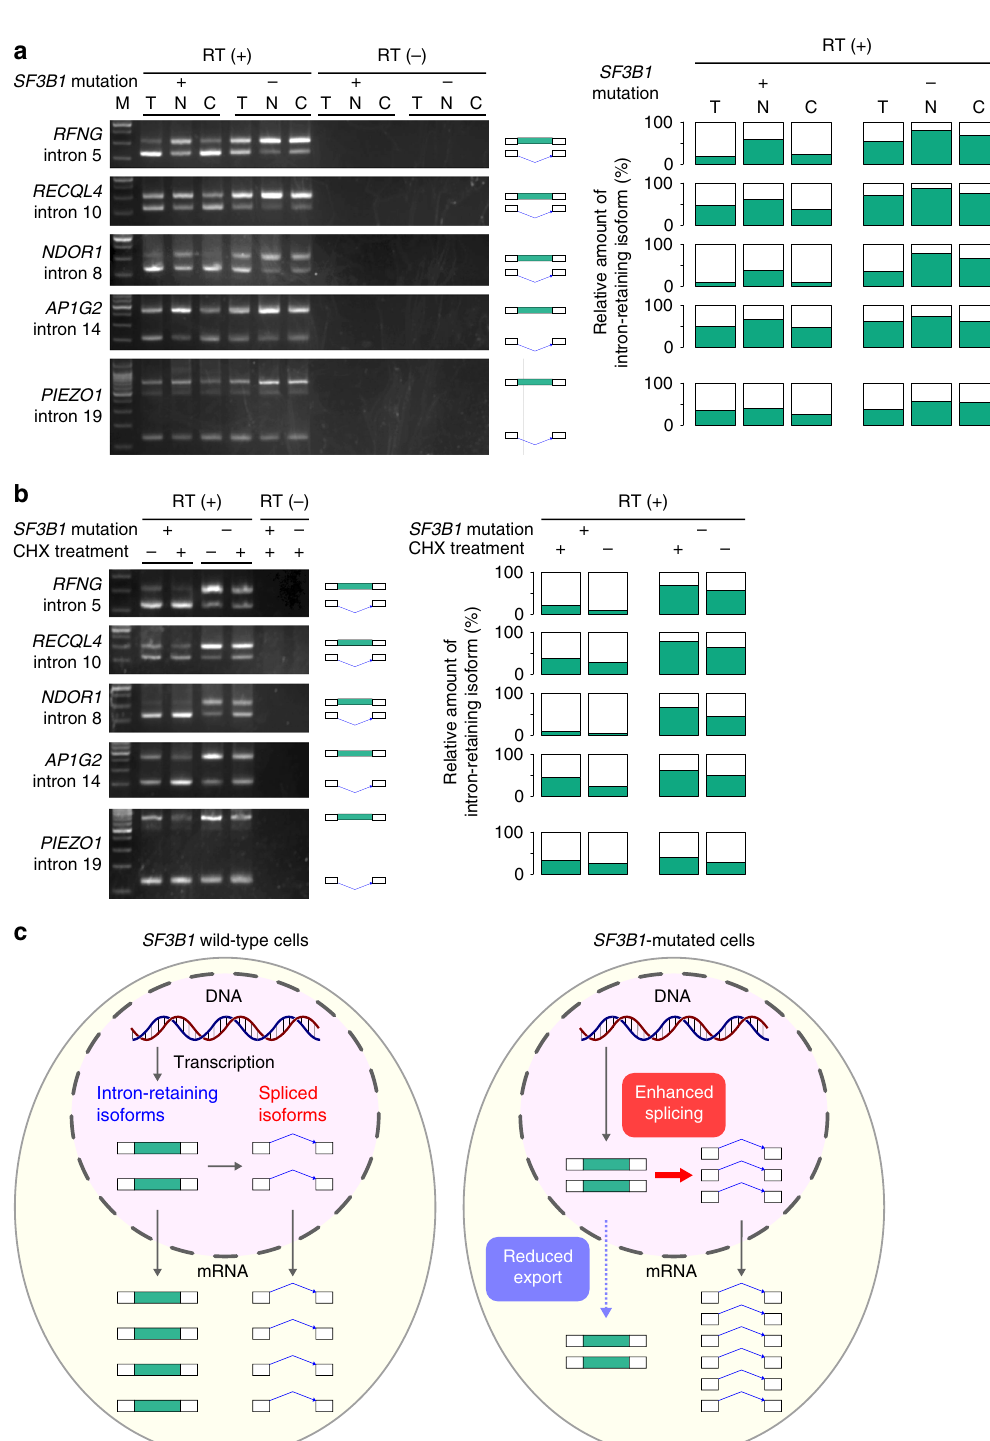
Fig. 6 Decreased intron retention in SF3B1 -mutated cells. a RT-PCR of several differentially spliced introns. RT-PCR was performed for total, nuclear, and cytoplasmic RNA extracted from CRISPR cells with or without a heterozygous SF3B1 K700E allele. Samples without reverse transcription (RT) were used as a negative control. T indicates total RNA; N, nuclear RNA; C, cytoplasmic RNA. Relative amount of the intron-retaining isoforms that were calculated from the intensity of bands are also shown on the right. b RT-PCR of several differentially spliced introns. RT-PCR was performed for cytoplasmic RNA with or without CHX treatment. Relative amount of the intron-retaining isoforms that were calculated from the intensity of bands are also shown on the right. c A schematic shows the amount of intron-retaining isoforms and spliced isoforms in the nucleus and the cytoplasm. The left panel is a schematic of SF3B1 wild-type cells, and the right is for SF3B1 -mutated